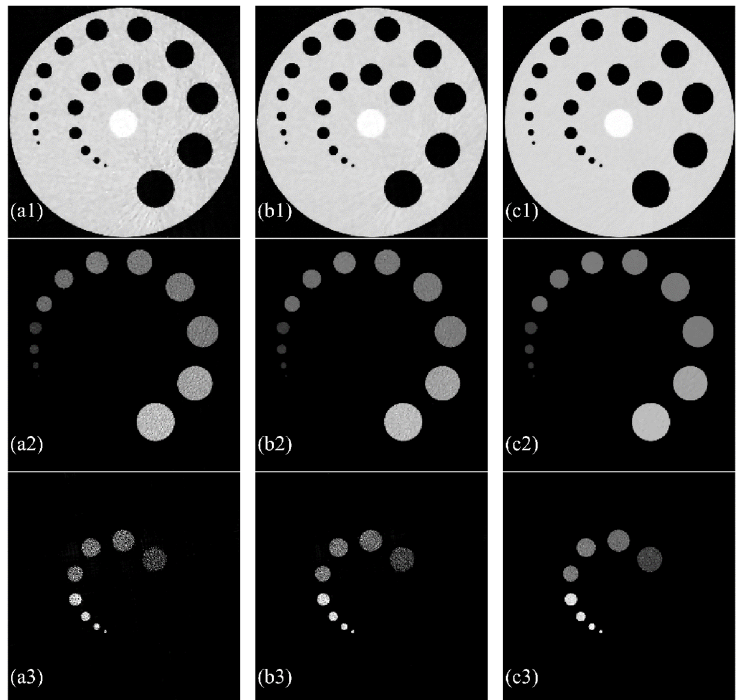
Figure 5. Three material reconstruction results of the proposed IPAD method at different noise levels. ( a1 – a3 ), ( b1 – b3 ), and ( c1 – c3 ) represent the tissue, bone, and iodine ob-tained by the proposed IPAD method at the noise I 0 = 5 × 10 5 , 1 × 10 6 , 5 × 10 6 , respectively. The display windows of the three materials are [0.01 1], [0.01 1], and [0.01 0.5], respectively.